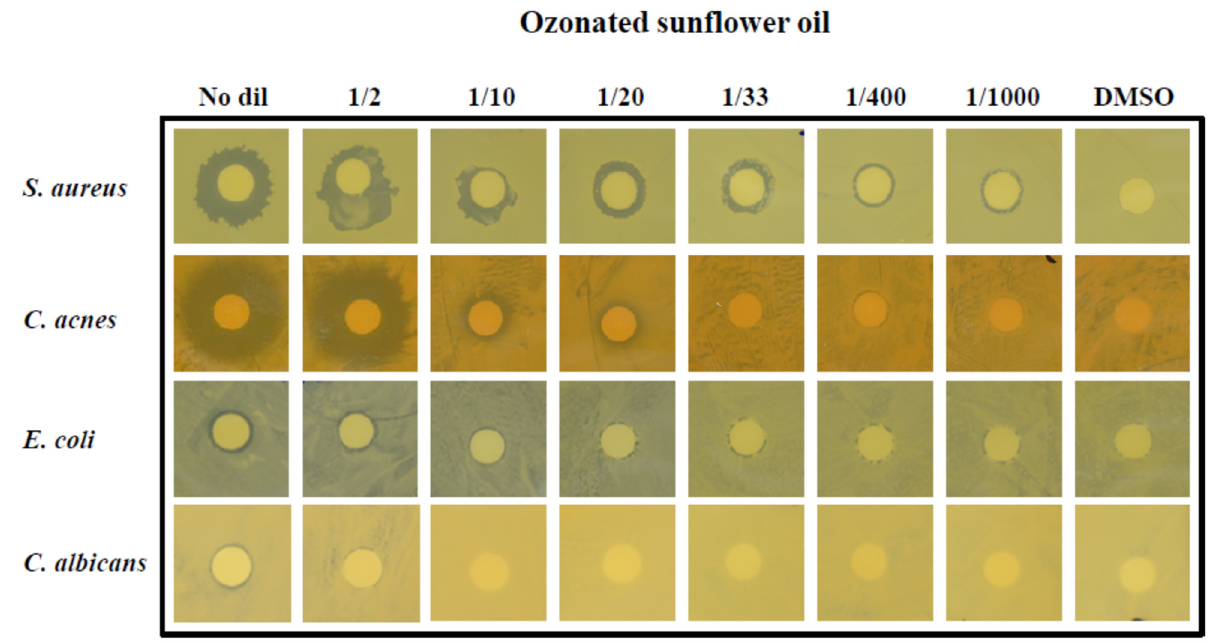
Figure 9. Survival of zebrafish embryos after a co-injection of oxLDL (15 ng of protein) plus ozonated sunflower oil (OSO) or sunflower oil (SO). Fluorescence image (Ex = 588 nm, Em = 605 nm) of a zebrafish embryo was obtained from dihydroethidium (DHE) staining, as described in the text. * p < 0.05 between OSO- and SO- injected embryo.